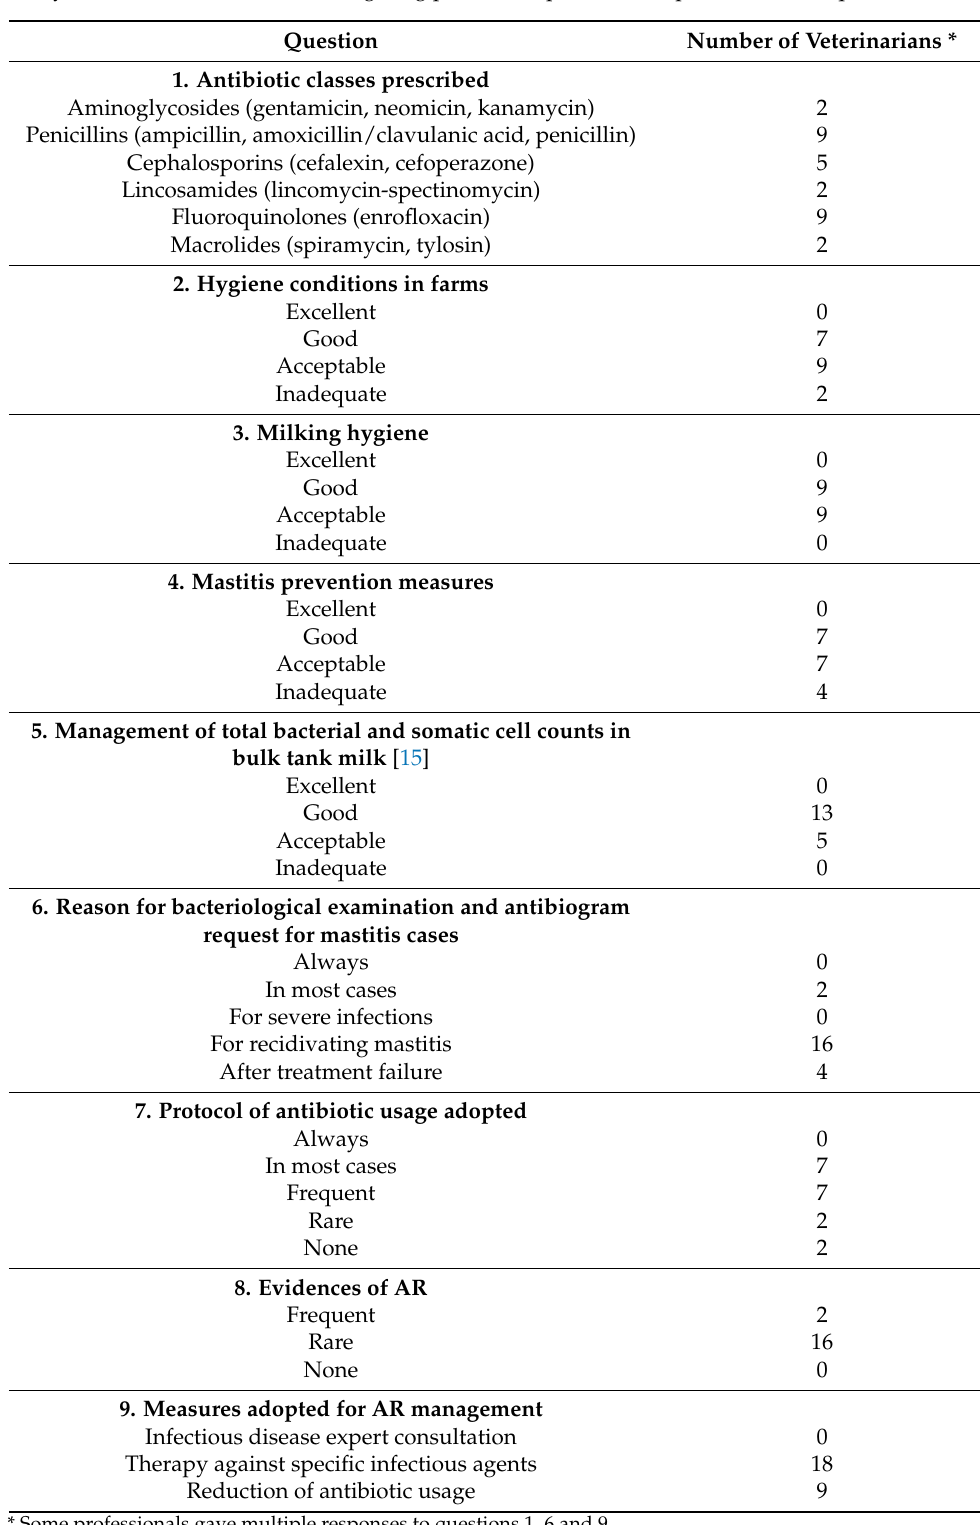
Table 3. Responses of 18 veterinarians to closed ended questions on antibiotic usage and mastitis management at farm level; all veterinarians provided medical care to the farms considered in this study. The number of veterinarians giving positive responses are reported for each